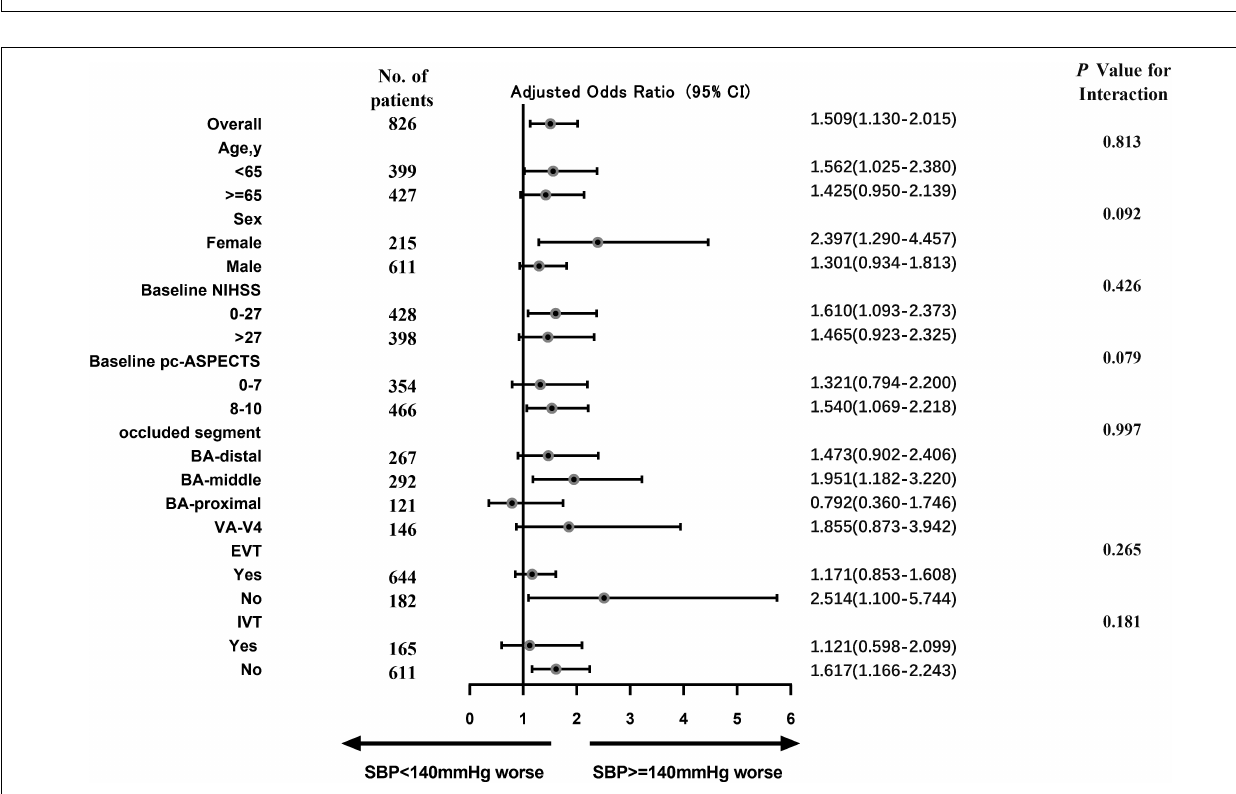
FIGURE 5 | This forest plot shows that the difference in the primary outcome (common odds ratio indicating the odds of deterioration of 1 point on the mRS at 90 days, analyzed with ordinal regression) between two SBP groups (SBP ≥ 140 mm Hg vs. SBP < 140 mm Hg) across all prespecified subgroups. The following variables are considered: hypertension, hyperlipidemia, atrial fibrillation, serum glucose, and stroke causative mechanism. The thresholds for baseline NHISS, baseline pc-ASPECTS, and age were chosen at the median. BA, basilar artery; EVT, endovascular therapy; and IVT, intravenous thrombolysis.